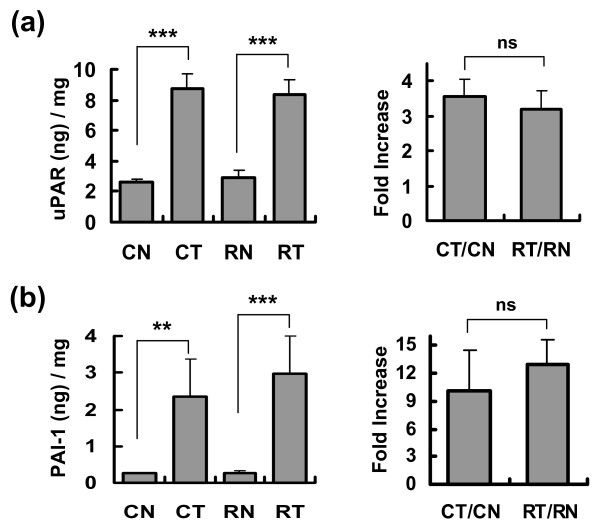
Expression of uPAR and PAI-1 in tumor tissues andadjacent normal mucosa of colon and rectal cancer patients. Mean concentration of uPAR (a, left panel) and PAI-1 (b, left panel) determined by ELISA. Fold increase of uPAR (a, right panel) and PAI-1 (b, right panel) in tumor tissues compared with normal tissues, showing no significant difference of increase in colon tumor and rectal tumor. ns, non-significant. **P < 0.01. ***P < 0.001.